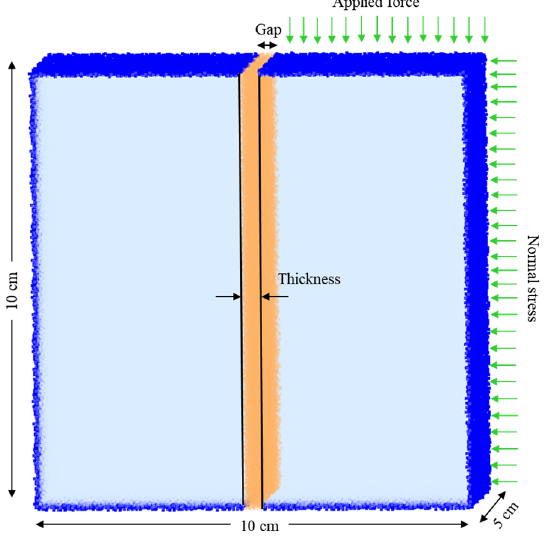
Figure 5. The geometry of the direct shear test sample with an infill thickness of 4 mm.